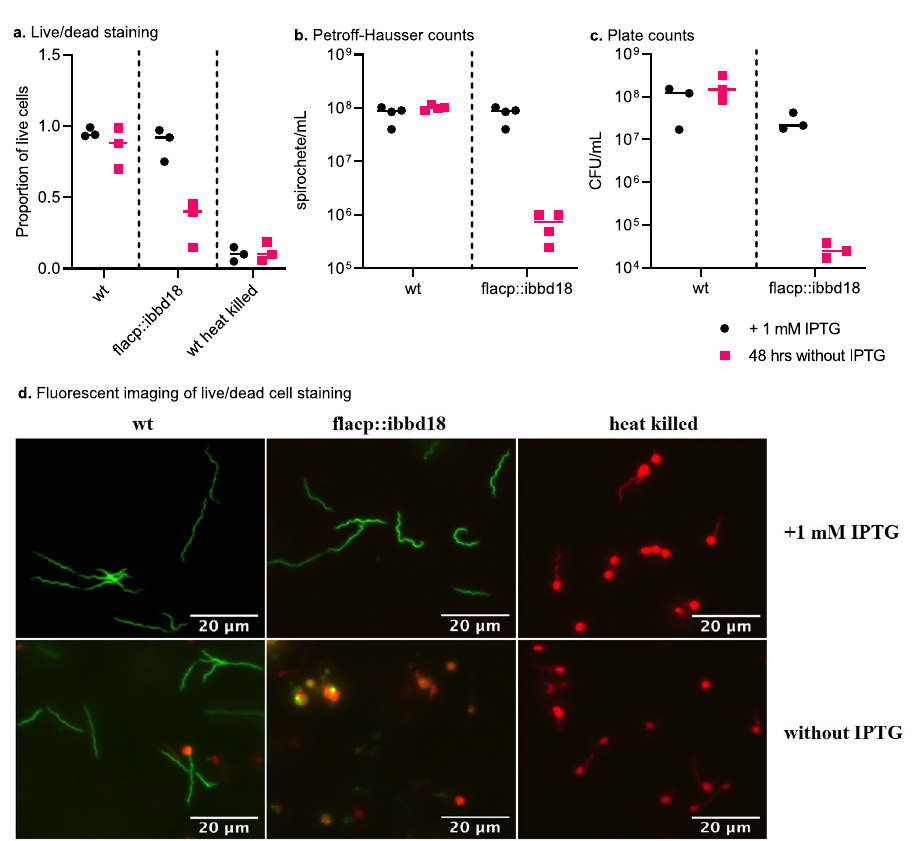
Fig. 2 | Lysis of fl acp::ibbd18 cells. a Live/dead staining was performed to deter- mine the proportion of live and dead cells; heat-killed wt cells were used as a control. b Dark fi eldmicroscopywasused todeterminethe numberof spirochetes per mL using a Petroff-Hausser counting chamber and c cells were plated to determineviablespirochetesasCFU/mLafter48hrs.withorwithoutIPTG.Dataare presented in all graphs as individual values of biological replicates with the mean